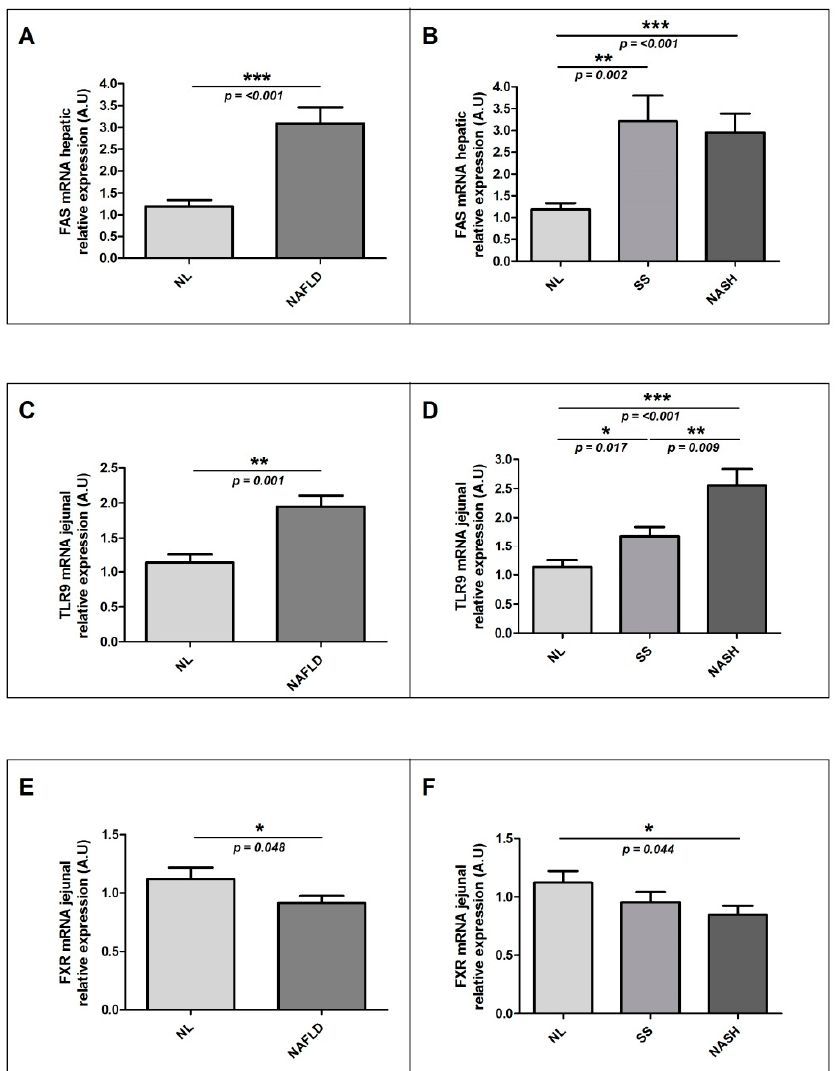
Figure 4. Differential relative mRNA levels of FAS in liver between ( A ) women with MO with NL histology and women with MO with NAFLD; ( B ) women with MO with NL histology, women with MO with SS, and women with MO with NASH. Differential relative mRNA levels of TLR9 in the jejunum between ( C ) women with MO with NL histology and women with MO with NAFLD; ( D ) women with MO with NL histology, women with MO with SS, and women with MO with NASH. Differential relative mRNA levels of FXR in the jejunum between ( E ) women with MO with NL histology and women with MO with NAFLD; ( F ) women with MO with NL histology, women with MO with SS, and women with MO with NASH. A.U, arbitrary units; MO, morbidly obesity; NAFLD, nonalcoholic fatty liver disease; NL, normal liver; SS, simple steatosis; NASH, nonalcoholic steatohepatitis; FAS, fatty acid synthase; TLR, toll-like receptor; FXR, farnesoid X receptor. p < 0.05 was considered statistically significant (* means p < 0.05; ** means p < 0.01; *** means p < 0.001).